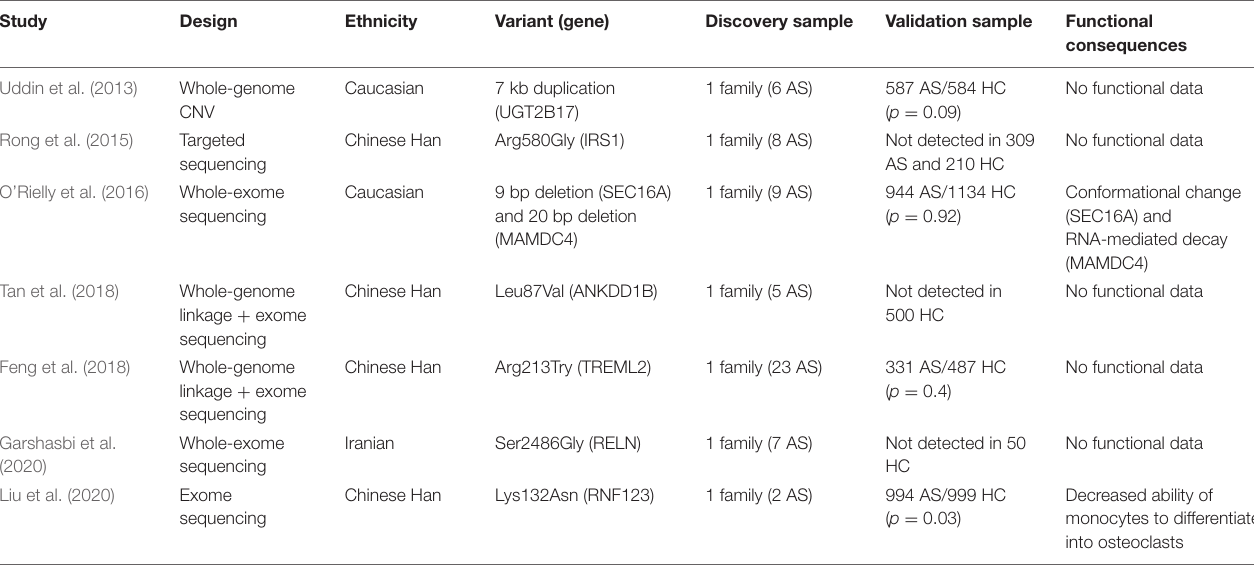
TABLE 1 | Family-based studies investigating rare variants in